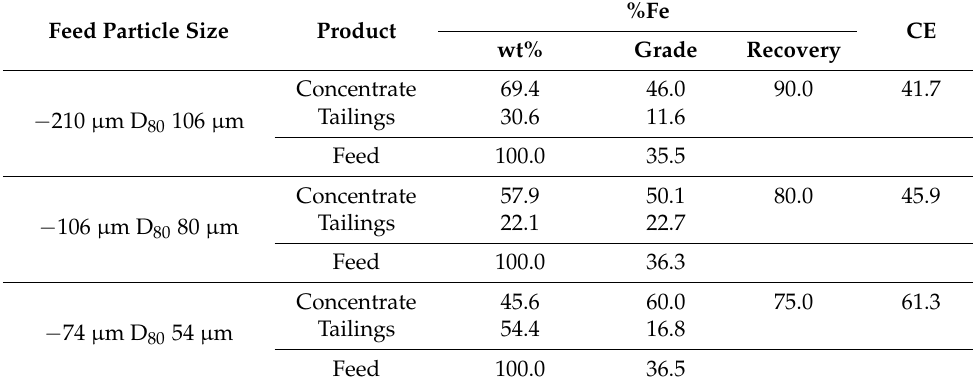
Table 3. Amenability to WHIMS by varying MOG intensity, 10,000 Gauss, and 6 mm ball